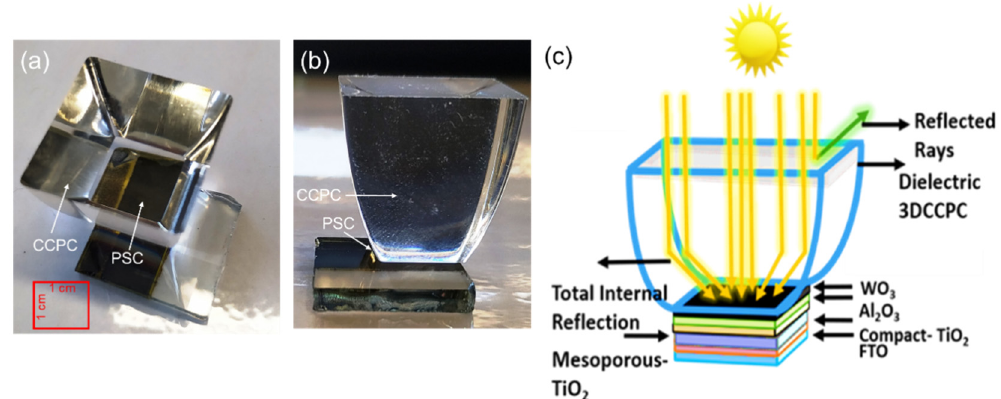
Figure 2. A ( a ) top-view and ( b ) side-view photograph of CCPC integrated PSC, with a ( c ) schematic diagram of the CCPC- integrated-PSC device, employing different PSC layers and light conditioning